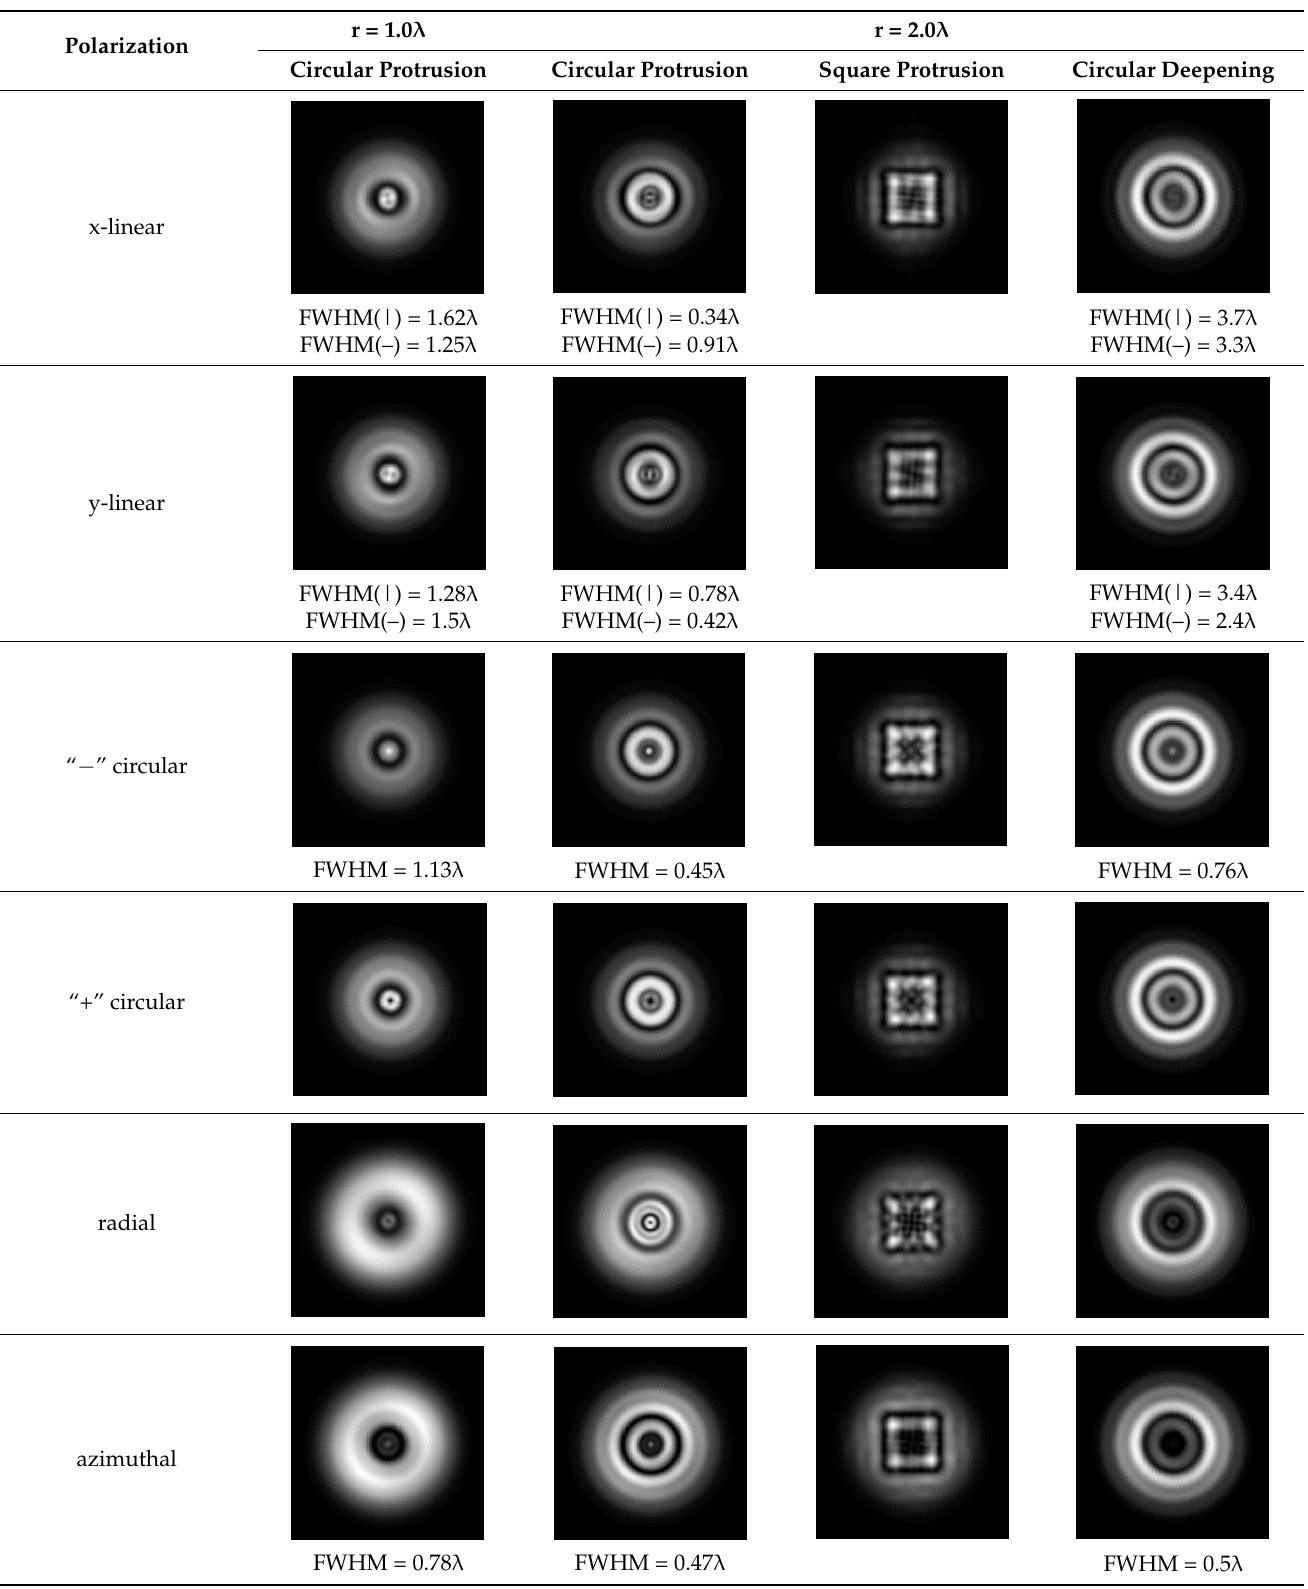
Table 2. The diffraction of Laguerre–Gauss mode (0,1) by surface micro-defects in plane xy ( z 1 = 0.5 λ ), | E | 2 , [ − 6.96 λ ; 6.96 λ ].